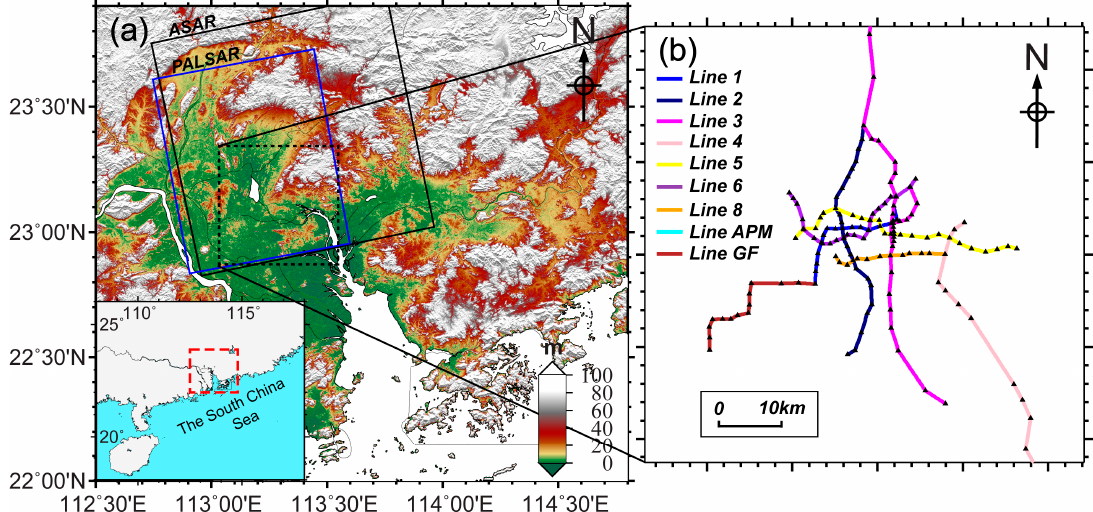
Figure 1. Study area and Synthetic Aperture Radar (SAR) data coverage. ( a ) Background setting (inset) of the research domain and the SAR data coverage. Black and blue rectangles represent the Advanced Synthetic Aperture Radar (ASAR) and Phased Array Type L-band Synthetic Aperture Radar (PALSAR) coverage, respectively; ( b ) Metro line distribution map of Guangzhou, including lines one, two, three, four, five, six, eight, APM, and GuangFo (GF). Black triangles are the subway station locations.